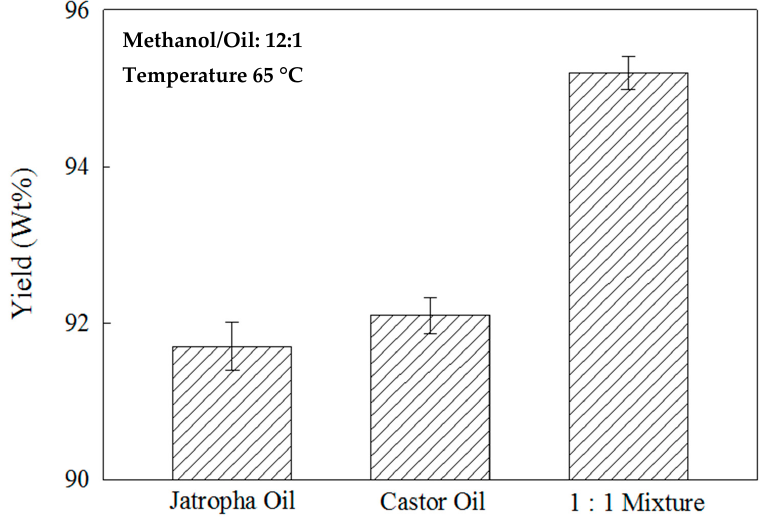
Methanol/Oil: 12:1